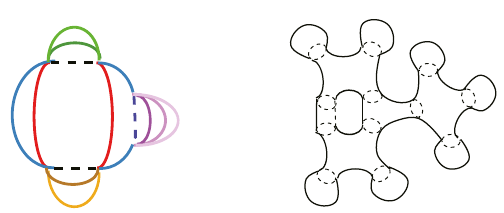
Figure 6 . Left: a Feynman diagram in the free energy of the disorder-averaged q = 4 SYK model, given by β − 1 ln Z = β − 1 lim M → 0 M − 1 Z M with Z M as in (A.6). Site indices for fermions have − − been distinguished with color. Right: corresponding three-dimensional